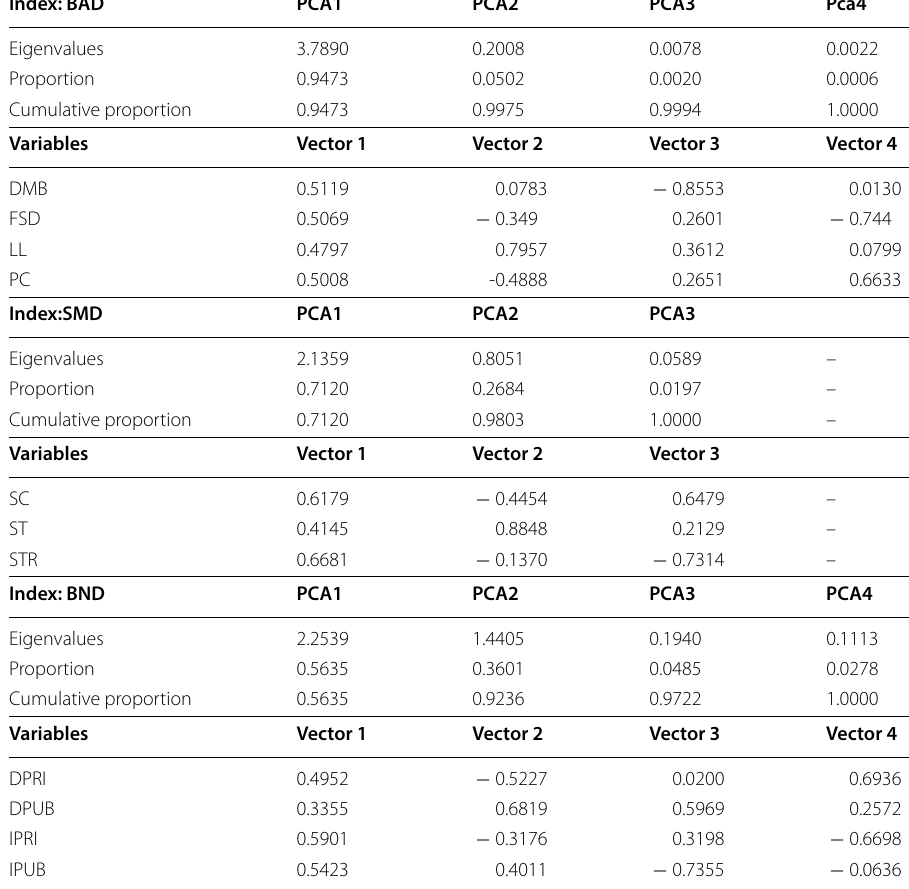
Table 1 Principal component analysis